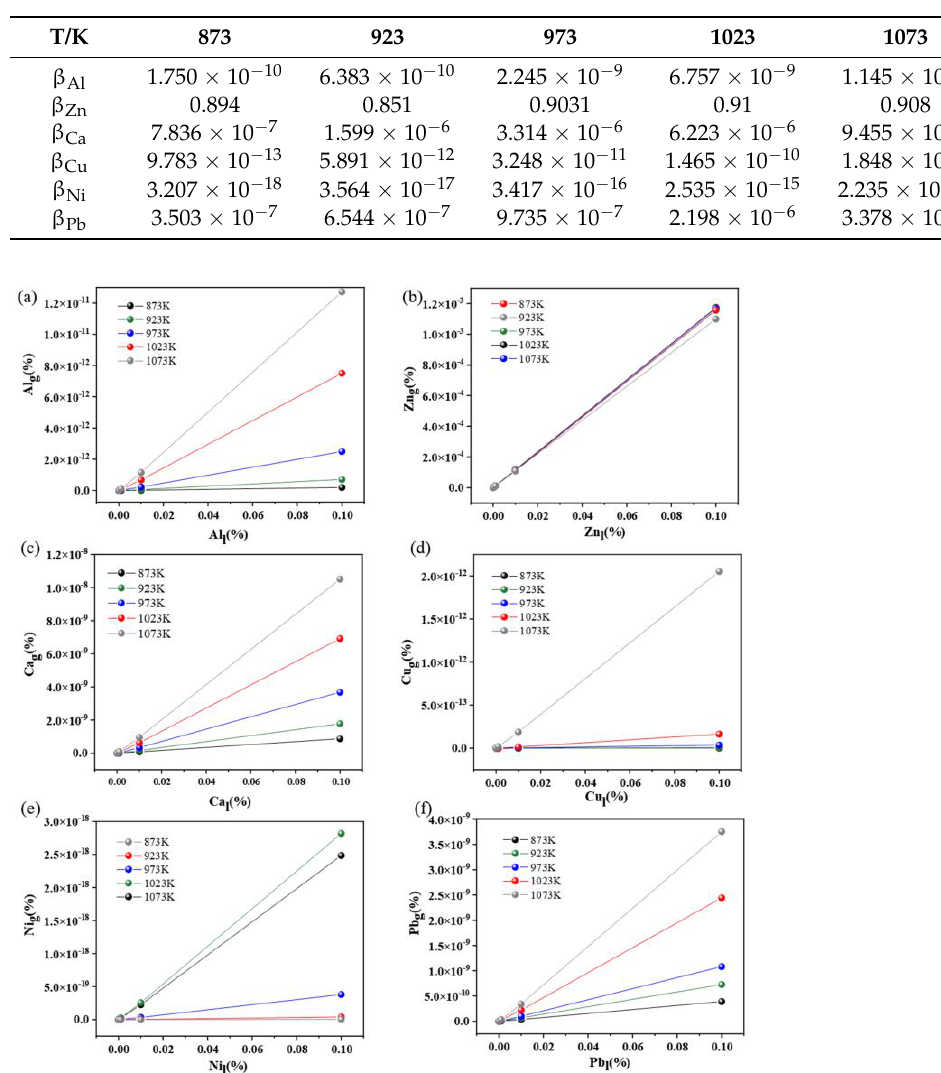
Table 1. The separation coefficients of impurities at different temperatures [26].